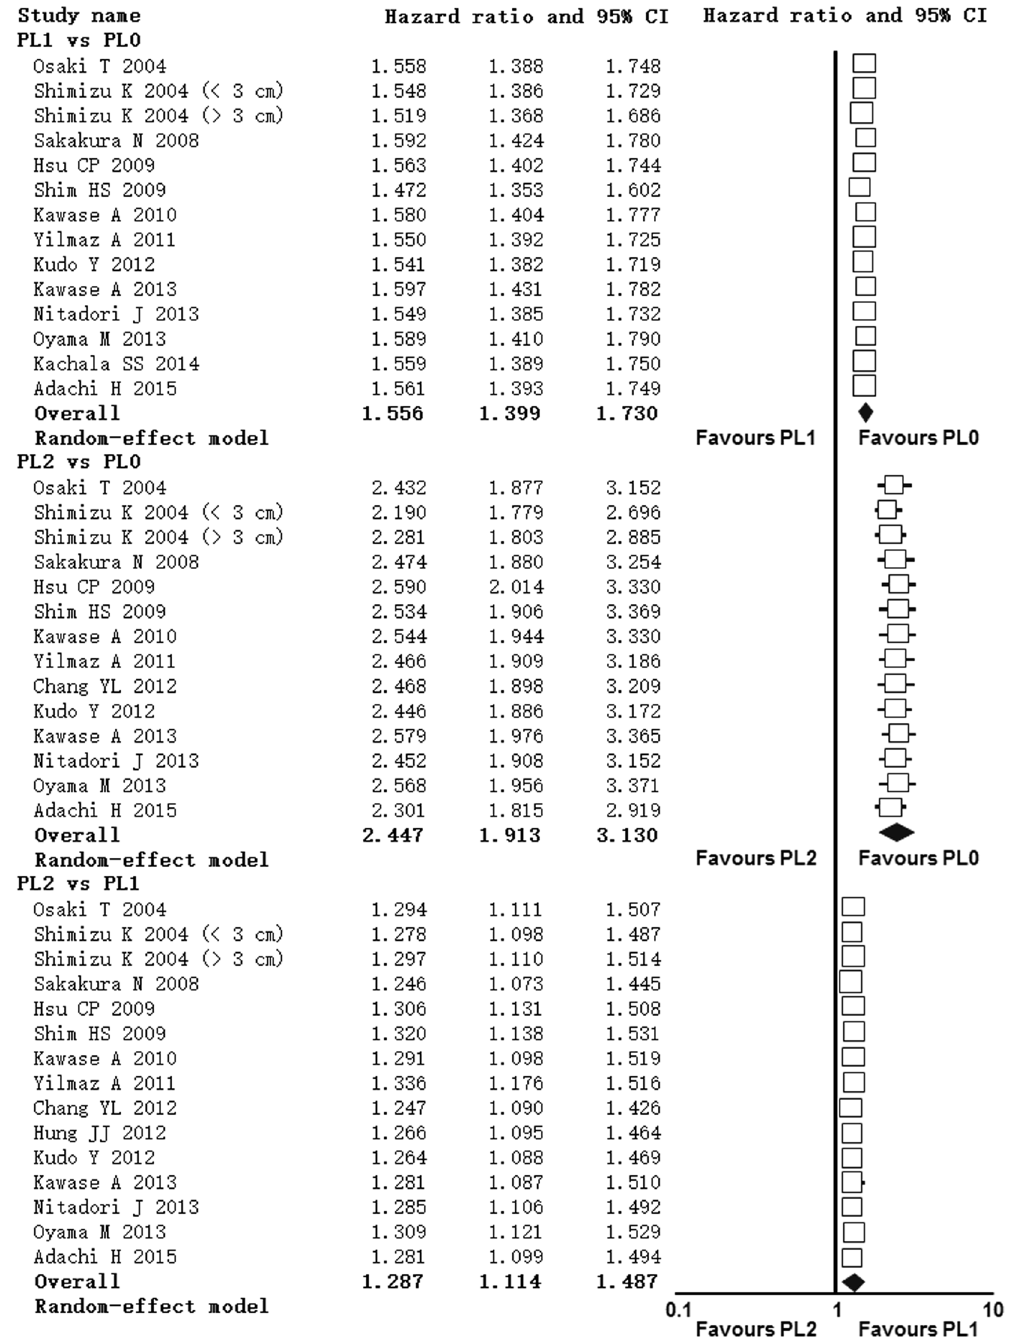
Figure 6. Forest plot showing the sensitivity analyses of overall survival. * CI: Confidence